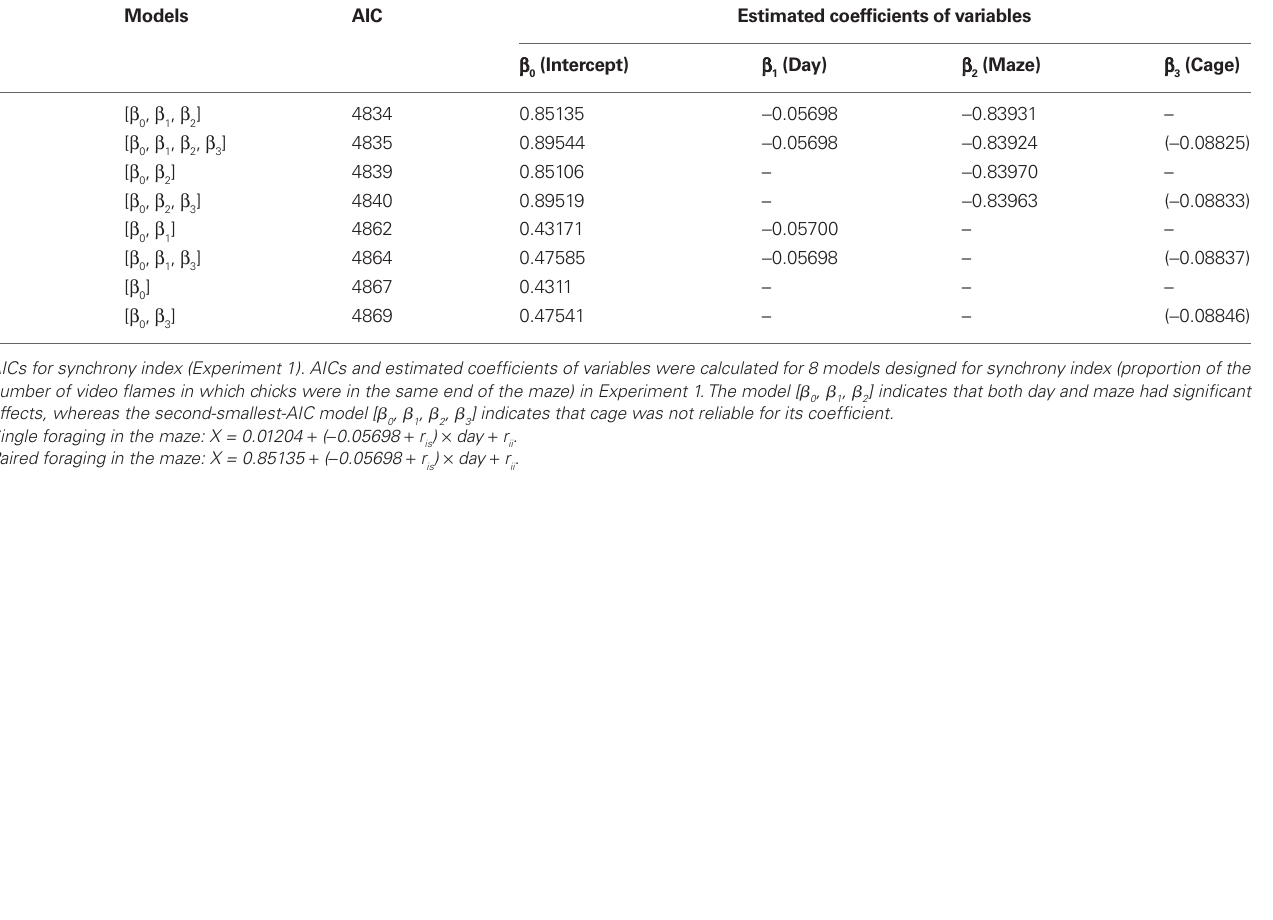
Table A2 | The day – maze model yielded the smallest